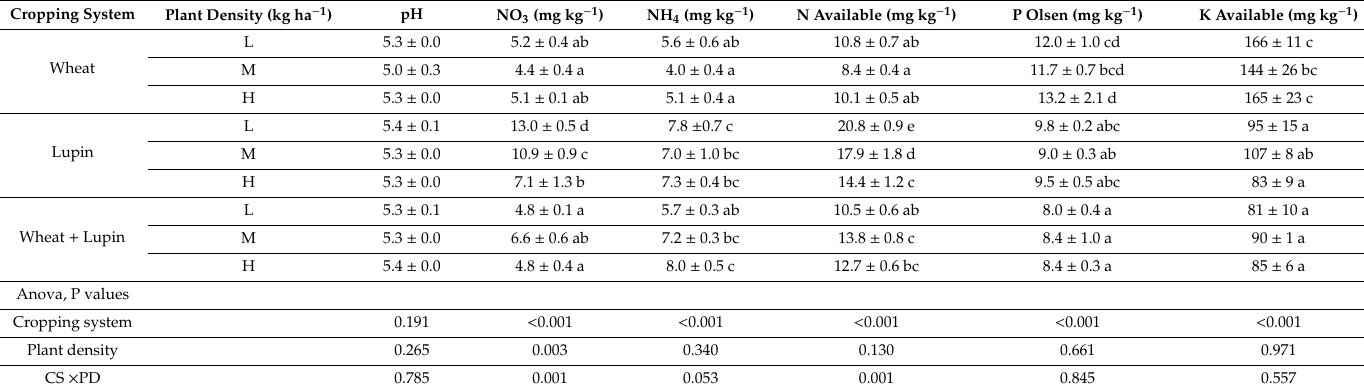
Table 1. Soil chemical properties in response to monocropping and intercropping at di ff erent plant densities under field conditions.